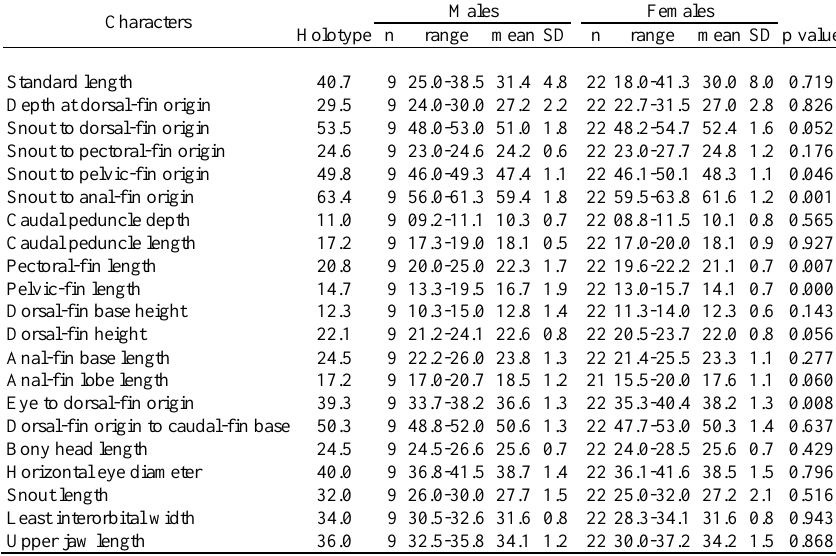
Table 1. Morphometrics of Bryconadenos weitzmani . Standard length is expressed in mm; measurements through head length are percentages of standard length; the last four entries are percentages of head length. Specimens are from MZUSP 98666 (holotype) and MZUSP 96558 and 96559